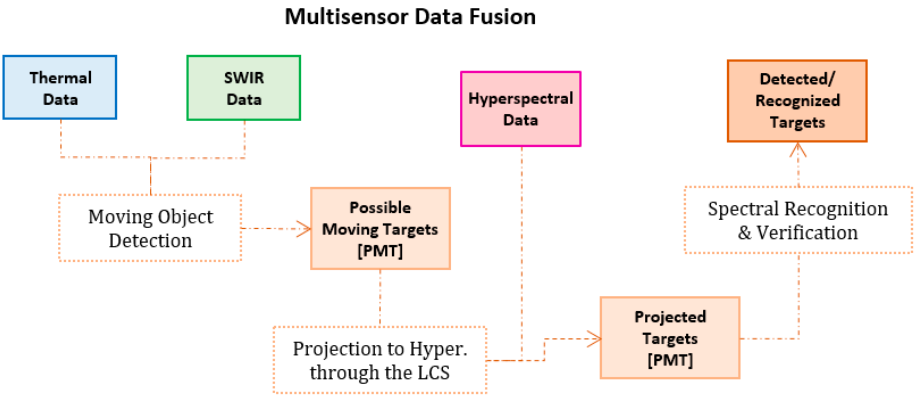
Figure 5. The developed processing pipeline for efficient multisensor data fusion.